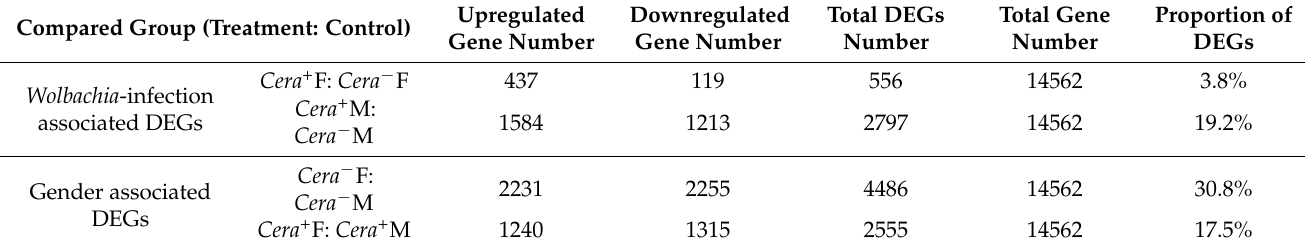
Table 1. Comparisons of the Differentially Expressed Genes (DEGs) of the fig wasps. Cera − : the fig wasp lineage noninfected with Wolbachia , Cera + : the fig wasp lineage infected with Wolbachia , F: female, M: male (e.g., Cera − F indicates female wasps with no infection of Wolbachia ); Upregulated gene number: the gene number upregulated in treatment when compared to the control; Downregulated gene number: the gene number downregulated in treatment when compared to the control; Total DEGs number: the summary of the up- and down-regulated genes; Total gene number: the total gene number analyzed in the study; Proportion of DEGs: the division of the total DEGs number to the total gene